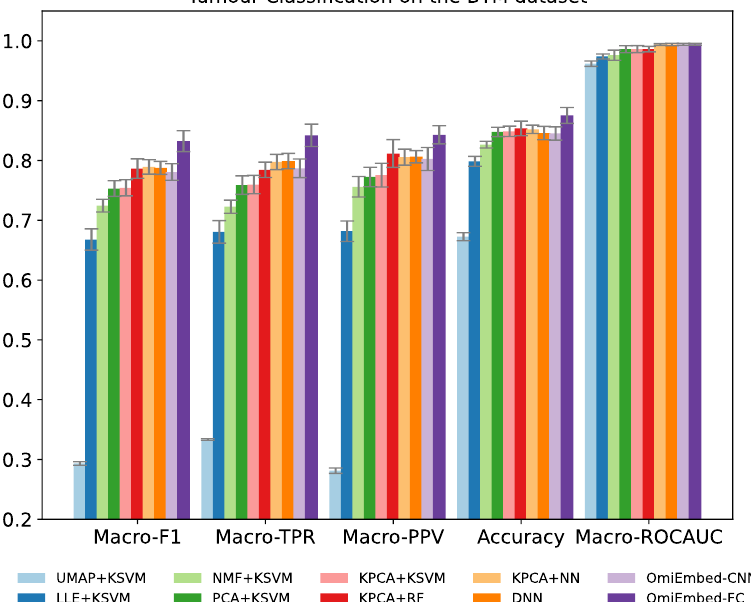
Figure 3. Performance comparison of OmiEmbed and other eight methods for the tumour entity classification task on the BTM dataset with the histopathological tumour type